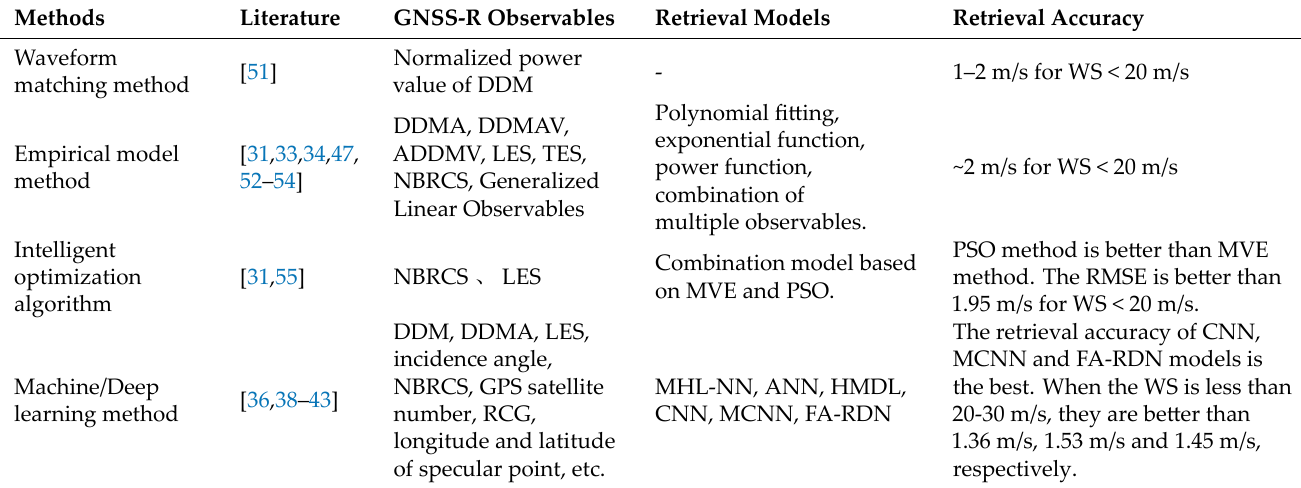
Table 1. Comparison of spaceborne GNSS‑R sea surface wind speed retrieval